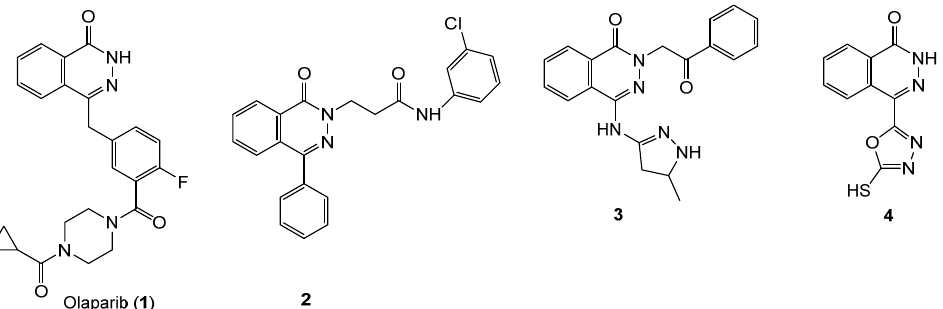
Figure 1. Structure of several phthalazinone derivatives with anticancer properties.